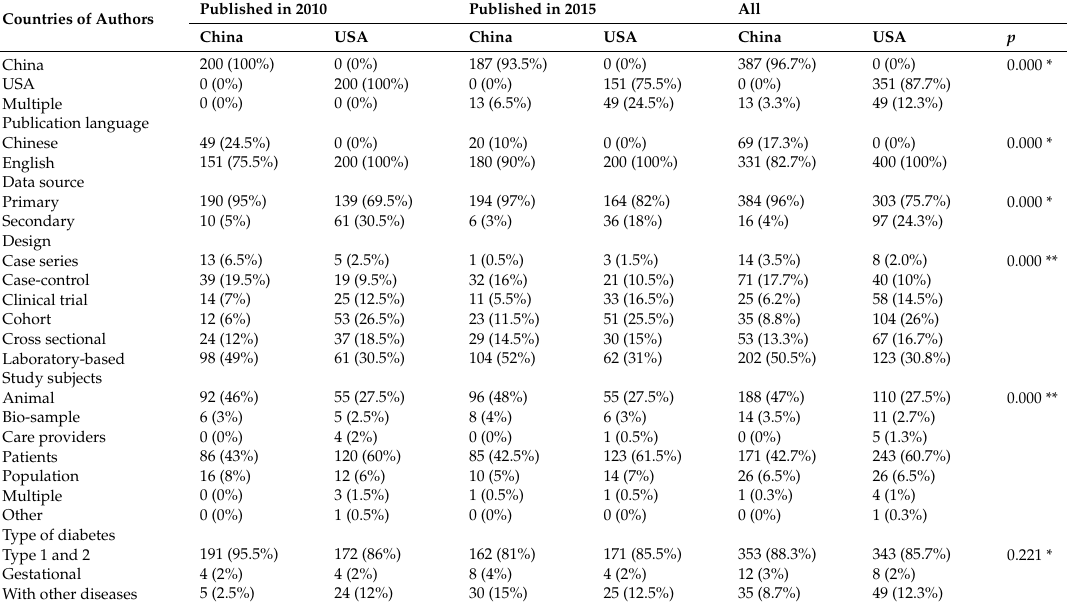
Table 1. The main characteristics of included